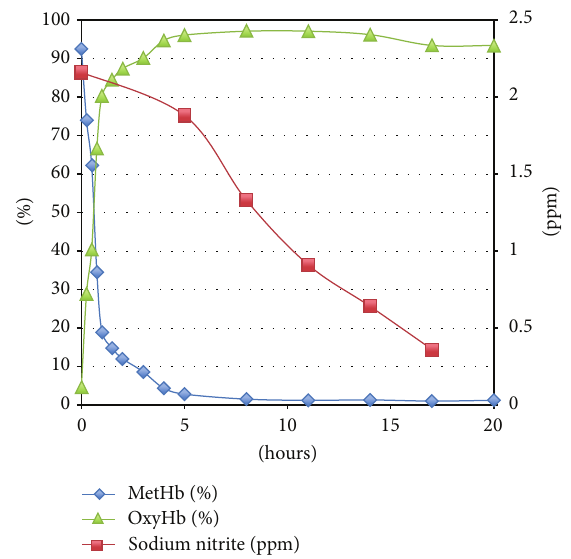
Figure 2: Changes in the serum concentration of sodium nitrite and percentages of methemoglobin and oxyhemoglobin after admission.